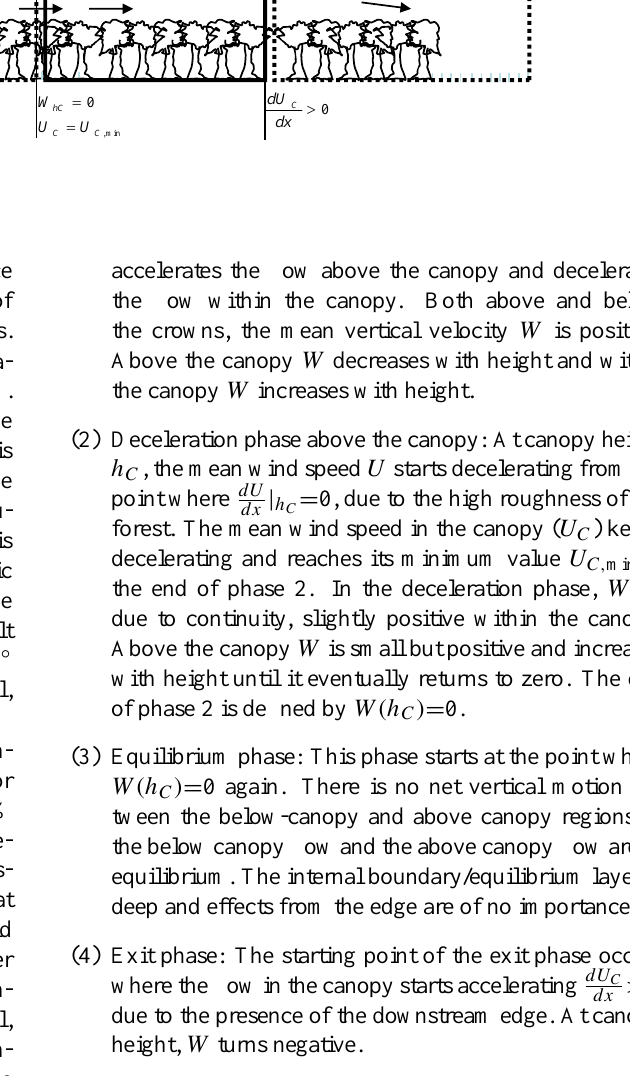
Fig. 2. Map and aerial photography of the Sorø site. The height contours (left pane) signify 2m height differences and the red box outlines the area in the photograph. The numbers in the right pane refer to the following features: 1. 8 h C to a large clearing in the direction of ≈ 60 ◦ from the mast, 2. Narrow strip of 17 h C homogeneous beech forest to forest edge in ≈ 90 ◦ , 3. 4 h C to a 15m tall plantation of Norway Spruce in 155 ◦ , 4. 13 h C to a clearing in 200 ◦ , 5. 10 h C to another 15m tall plantation of Norway spruce in 225 ◦ , 6. 17 h C to the forest